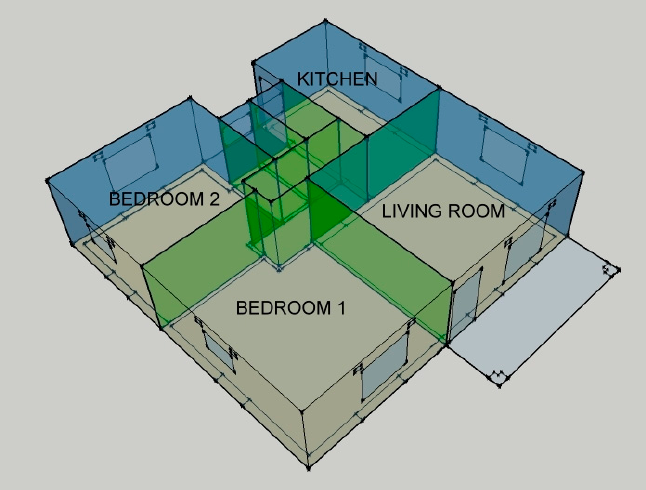
Figure 5. Building model thermal zones.